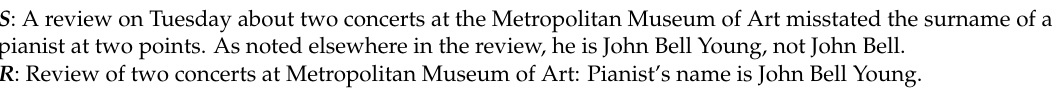
Table 1. Two examples on text summarization that show the importance of topic